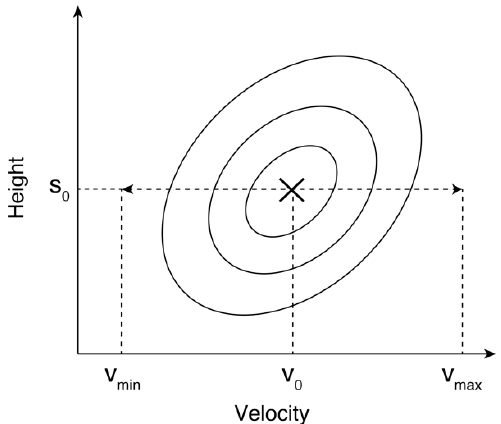
Figure 3. The single scattering point is selected, where the scattering distribution (temporal coherence) is the maximum. Conventional PSI (ConvPSI) uses a single elevation s 0 and a mean velocity v 0 , and non-parametric non-linear PSI (NN-PSI) uses a single elevation and the profile ( v min through v max ) of the temporal coherence for the displacement